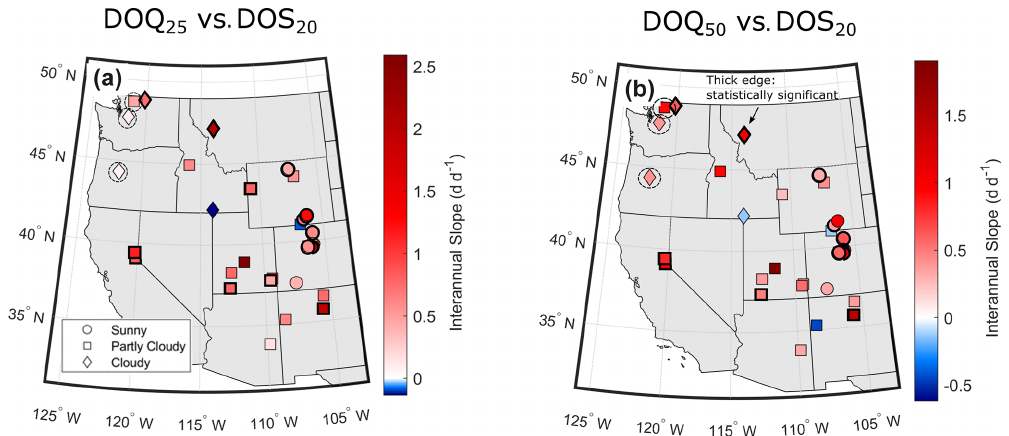
Figure 6. Spatial variability in the watershed-level interannual slopes for (a) DOQ 25 versus DOS 20 and (b) DOQ 50 versus DOS 20 . Wa- tersheds with statistically significant relationships are highlighted in symbols with thicker edges and are associated with those presented in Fig. 5. Watersheds that fall far from the linear regression presented in Fig. 5 are surrounded by a circle with a dashed line. Symbols are asso- ciated with the mean annual percentage of snowmelt days under clear-sky conditions. Sunny sites (circles) have > 90% clear-sky snowmelt days, partly cloudy sites (squares) have between 70% and 90%, and cloudy sites (diamonds) have < 70%. Clear-sky snowmelt days are defined as those with more than 80% of the potential clear-sky solar radiation.